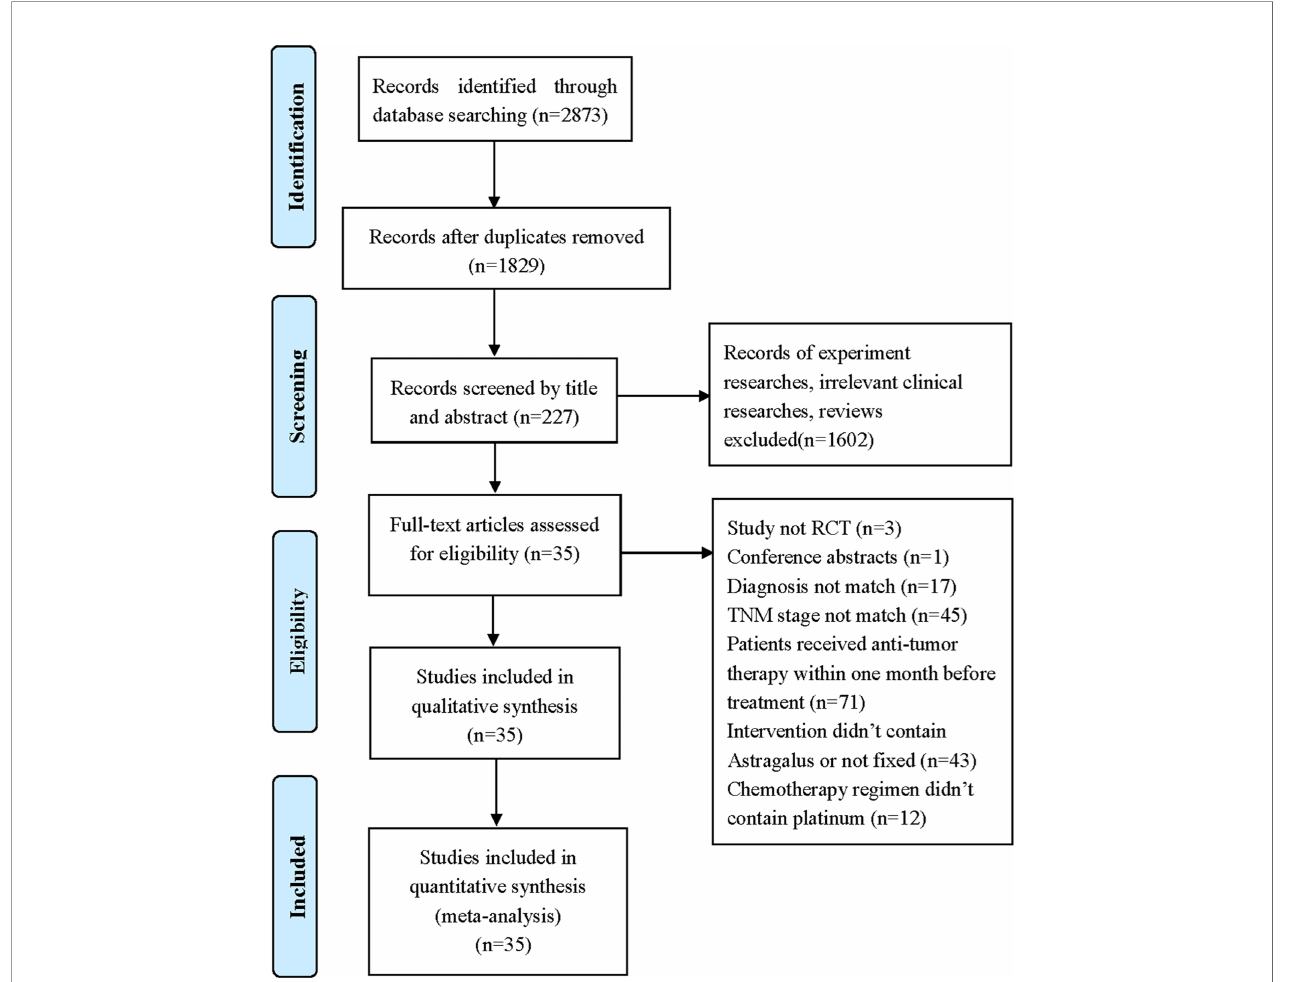
FIGURE 1 | Flow diagram of selection process